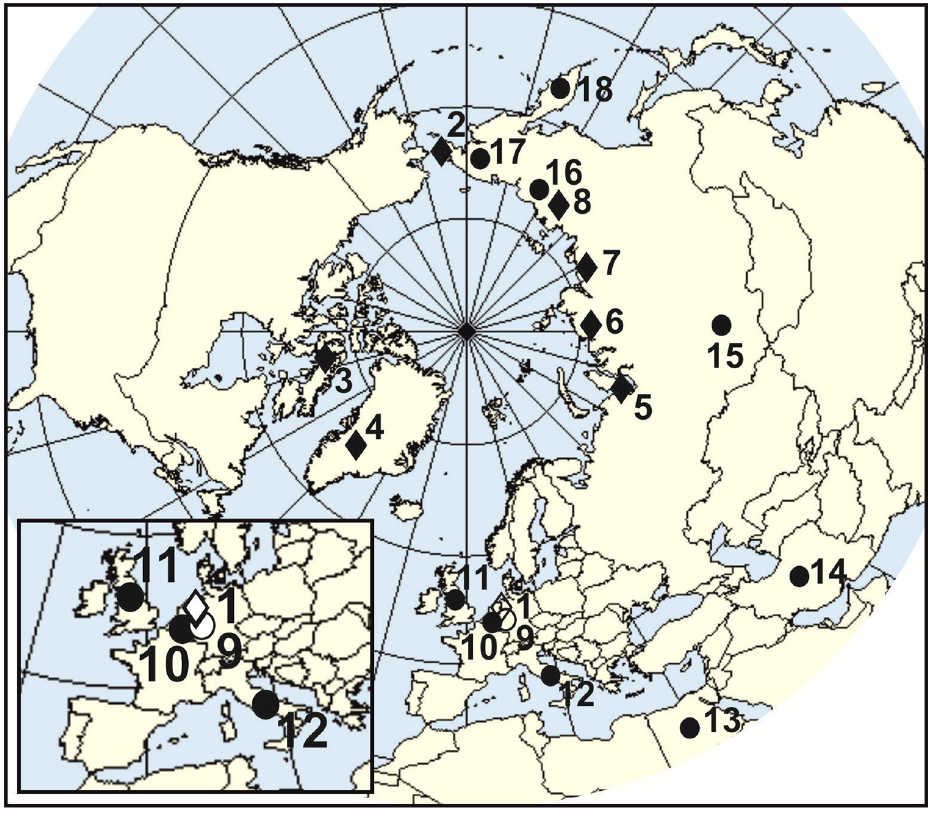
Fig 1. Geographic distribution of the recent and fossil samples of the arctic Vulpes lagopus and red foxes Vulpes vulpes used in the study. Black rhomb–recent populations of the arctic fox measured by Szuma (2011), empty rhomb– fossil populations of the arctic fox measured by Szuma for the study, grey circle–recent populations of the red fox measured by Szuma (2011); empty circle–fossil population of the red fox measured by Szuma for the study. Information about the samples can be found in Table